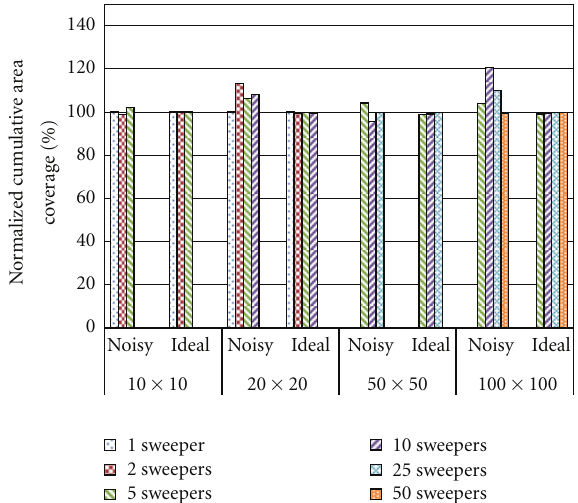
Figure 12: Area coverage in noisy versus ideal sensor